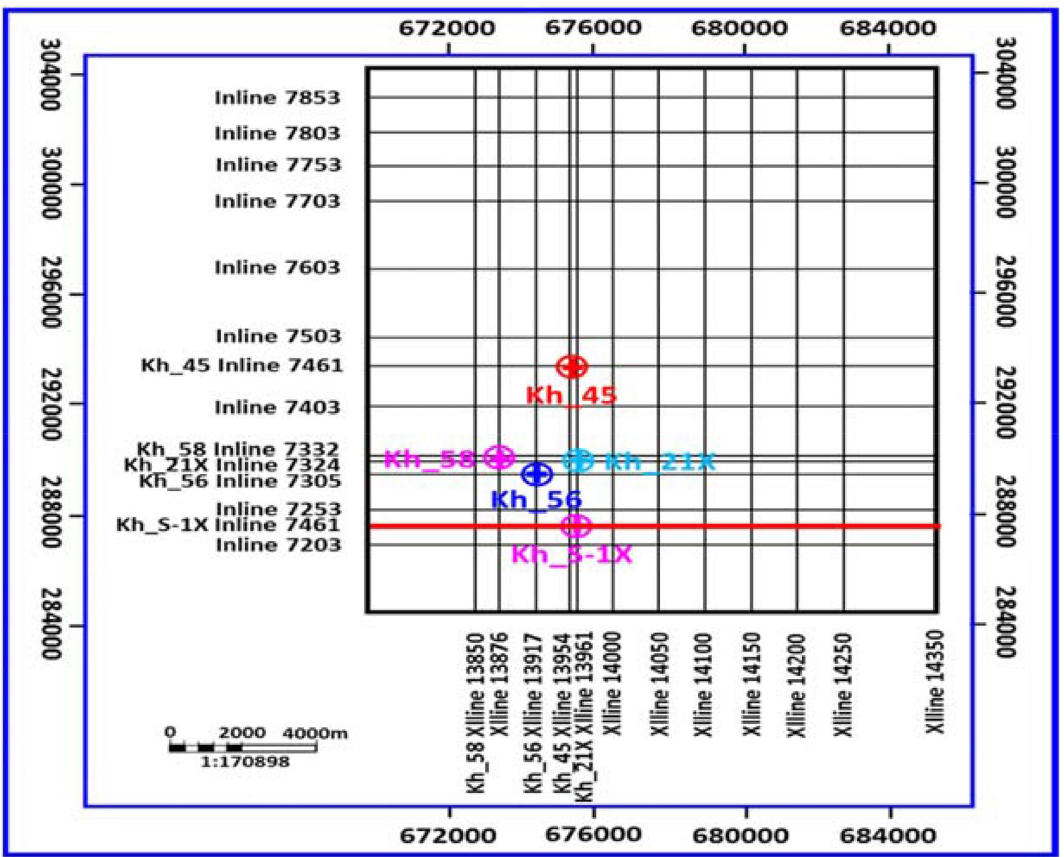
Fig. 7 Seismic in-lines (E–W direction) and cross-lines (N–S direction) are shown on the Khalda Field location map. Locations of interpreted seismic sections are represented by colored